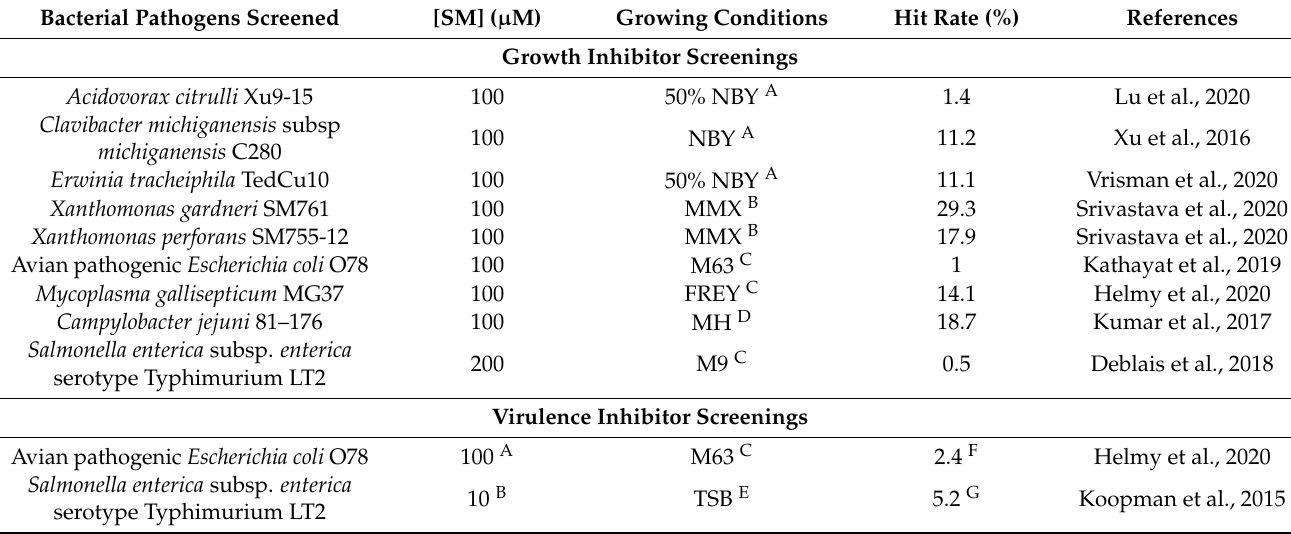
Table 1. Antimicrobial screening conditions and hit rates by